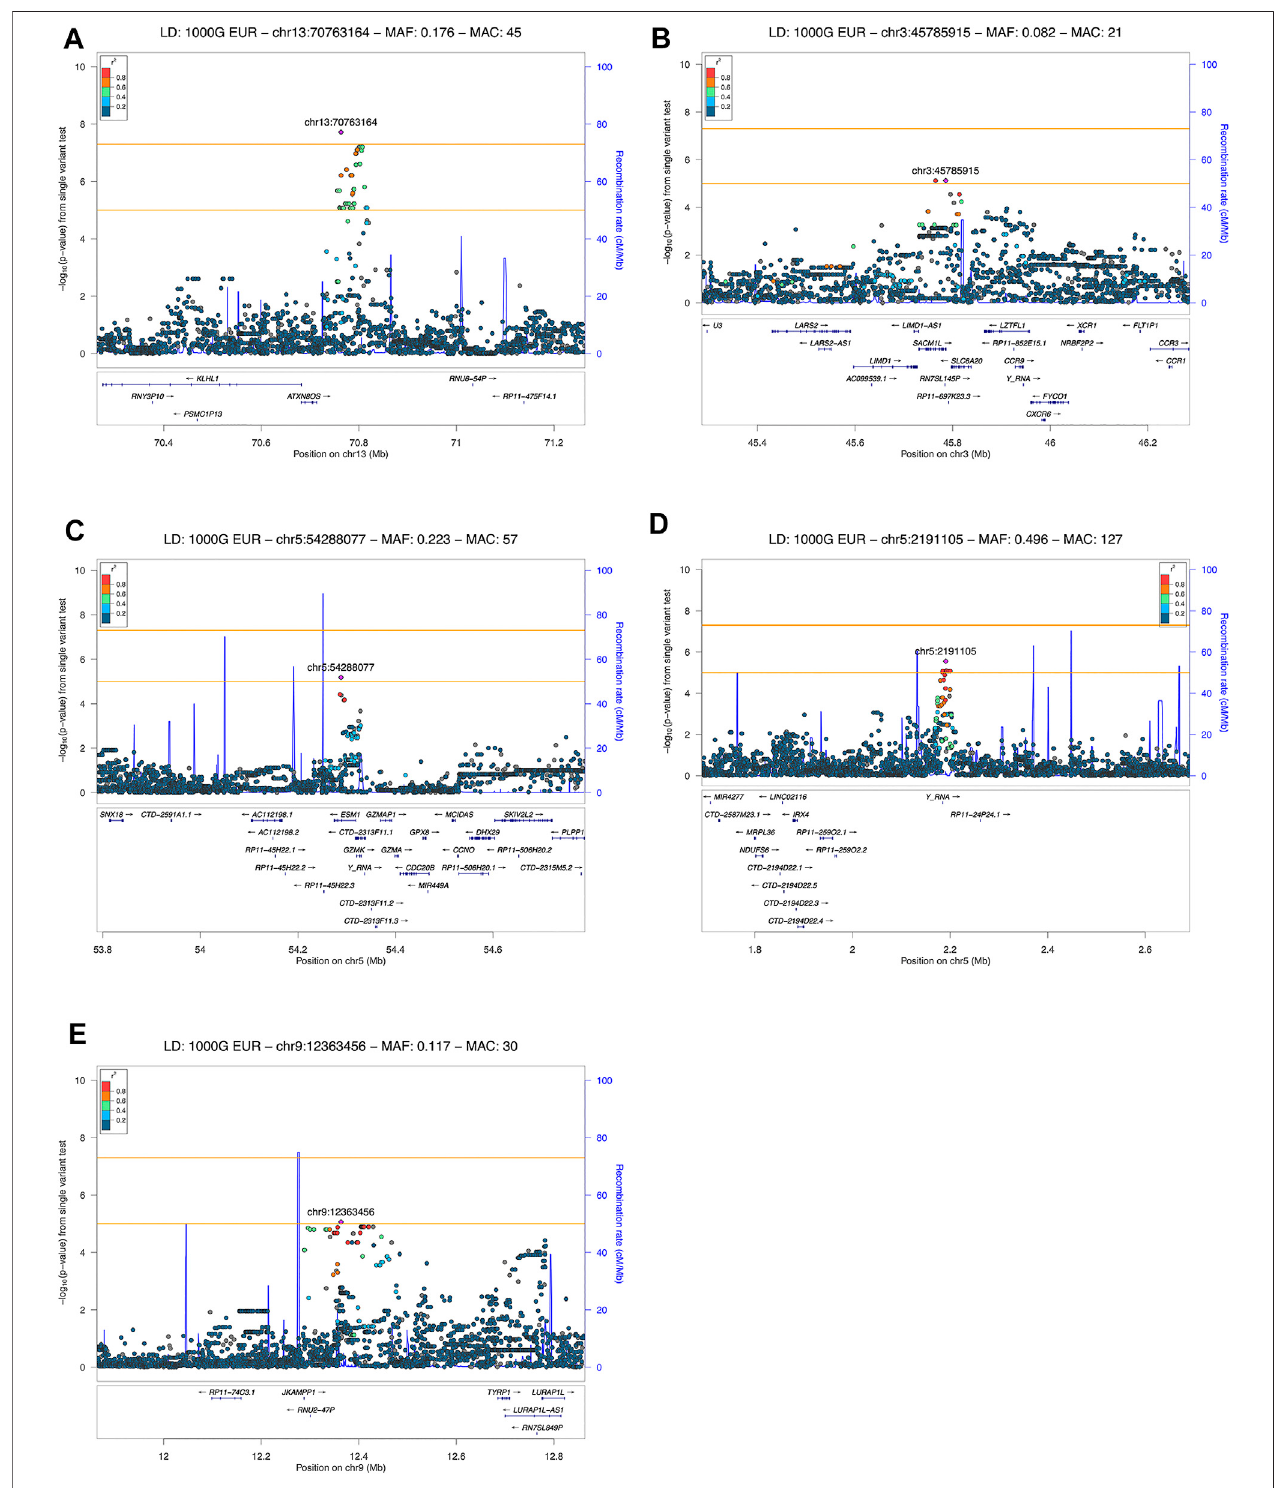
FIGURE 2 | LocusZoom plot showing the regional association of GWAS variant enriched loci with COVID-19 severity (severe and moderate versus mild patient groupcomparison).Variantsinlinkagedisequilibriumwiththeleadvariantareshownincolorgradientindicatingr 2 levels(hg19,1KGP,Phase3 — November2014,EUR): (A) 13q21.33 with rs61964606 as the lead variant; (B) 3p21.31 with rs73060324 as the lead variant; (C) 5p15.33 with rs13176661 as the lead variant; (D) 5q11.2 with rs78317595 as the lead variant; (E) 9p23 with rs1331359 as the lead variant.